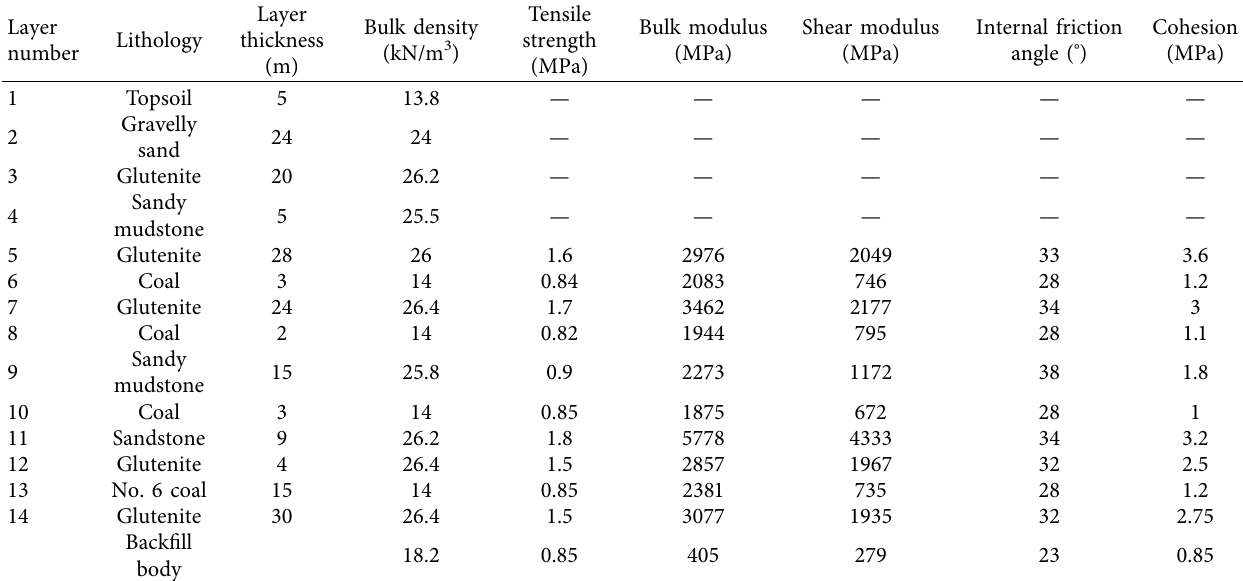
Figure 13: Model boundary conditions. Table 7: Physical and mechanical parameters of coal seam and overlying